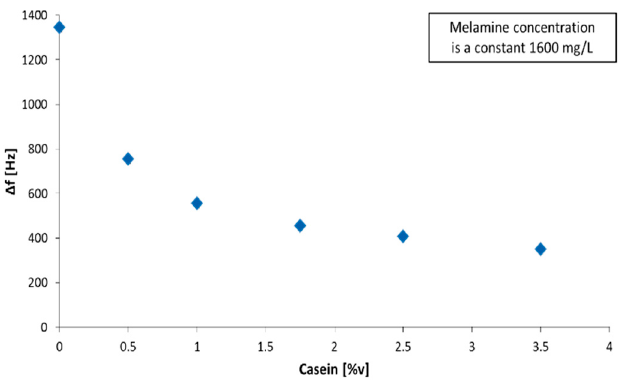
Figure 5. Sensor responses at a constant concentration of 1600 mg / L melamine, but at varying casein content.